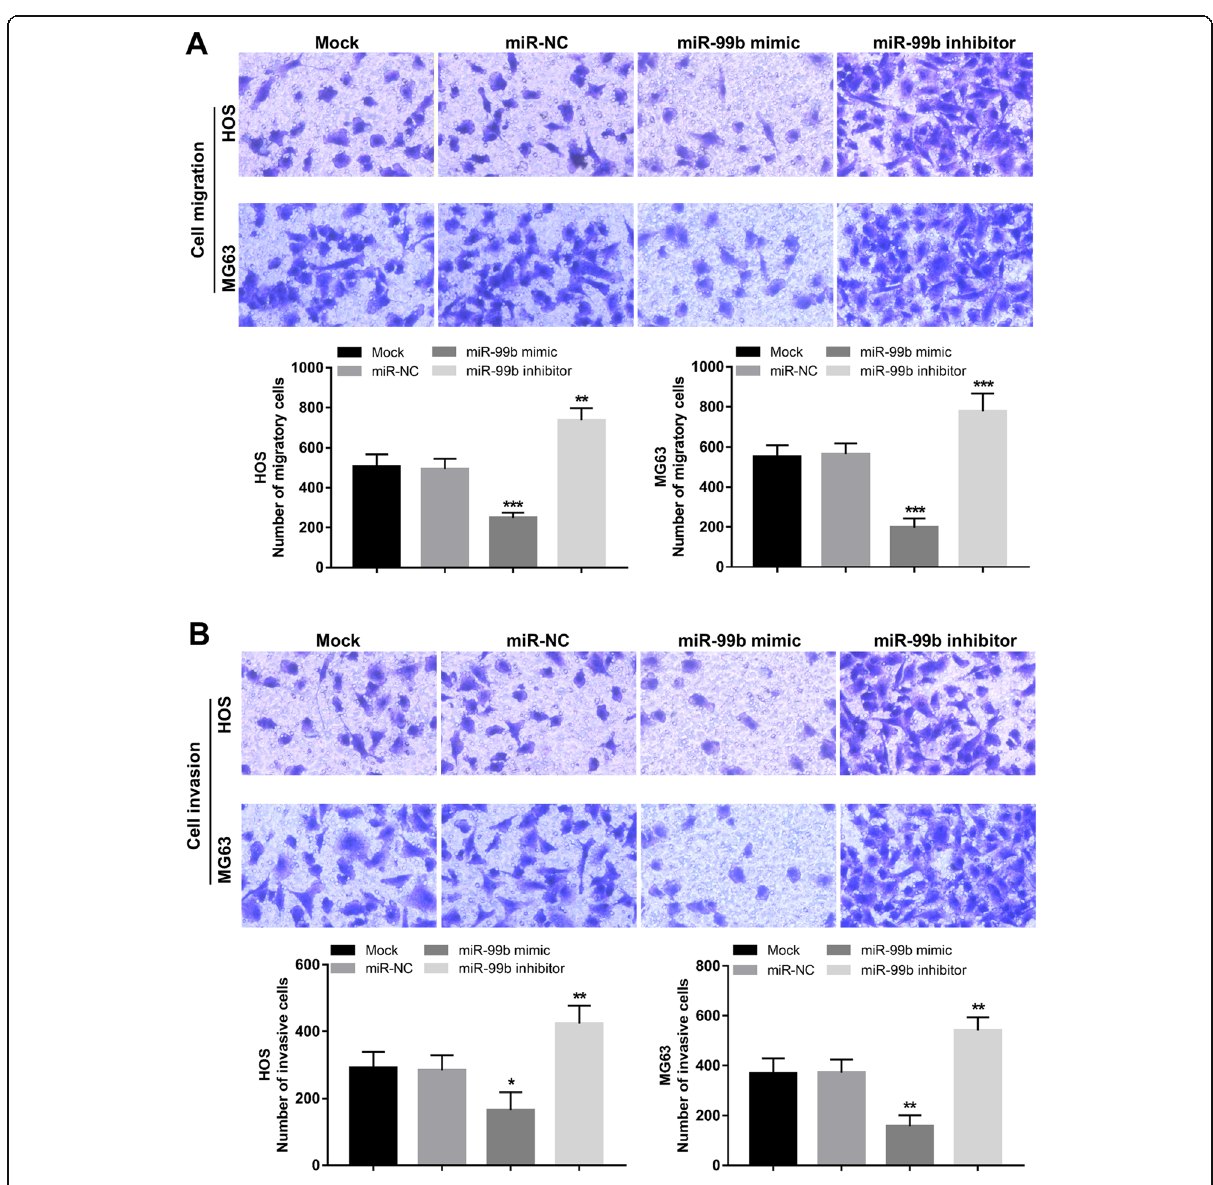
Fig. 4 Effects of miR-99b on cell migration and invasion of HOS and MG63 cells. The overexpression of miR-99b in HOS and MG63 could suppress the cell migration ( a ) and invasion ( b ), but the reduction of miR-99b led to the opposite results. * P < 0.05, ** P < 0.01, ** P <